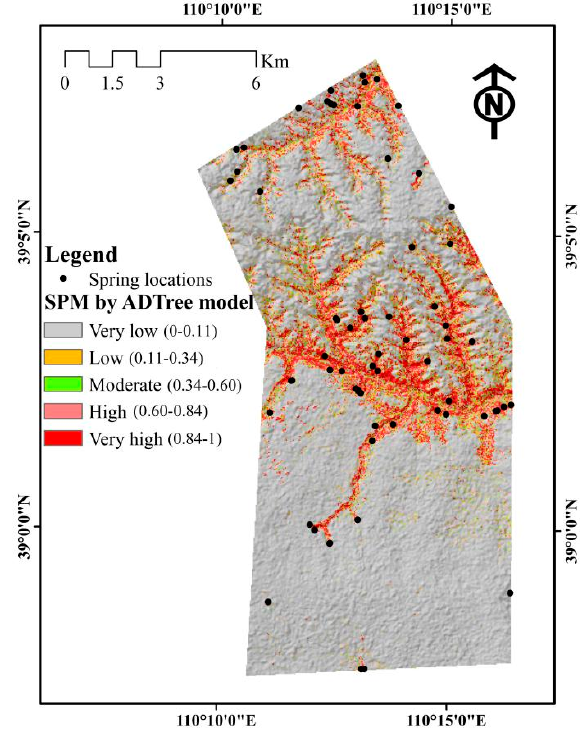
Figure 8. Groundwater spring potential map by the ADTree